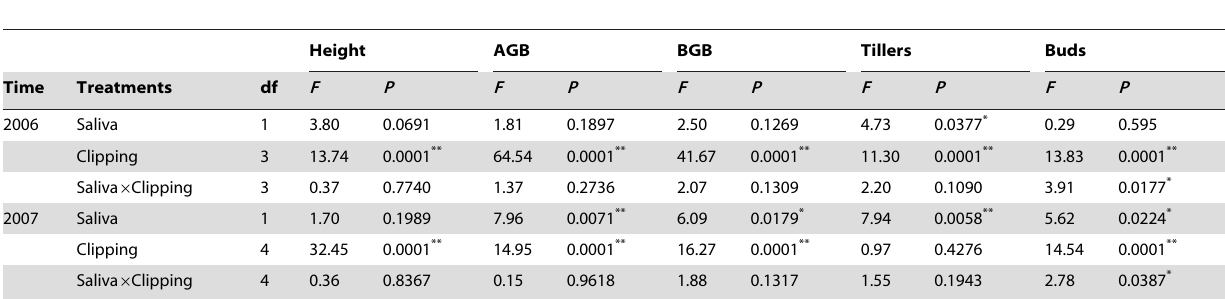
Table 2. Results of two ways ANOVA for the effects of saliva, clipping and their interaction on height, aboveground biomass (AGB), belowground biomass (BGB), tillers and buds both in 2006 and 2007.